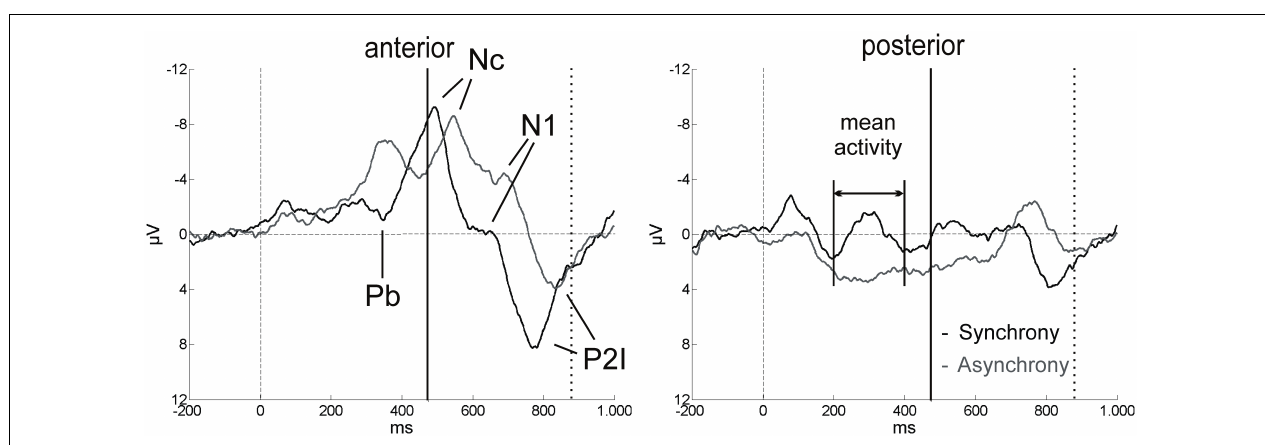
Solid vertical lines at 474ms indicate the auditory onset in both experimental conditions.The visual clapping of the hands occurred at 874ms in the asynchronous condition (indicated by dotted vertical